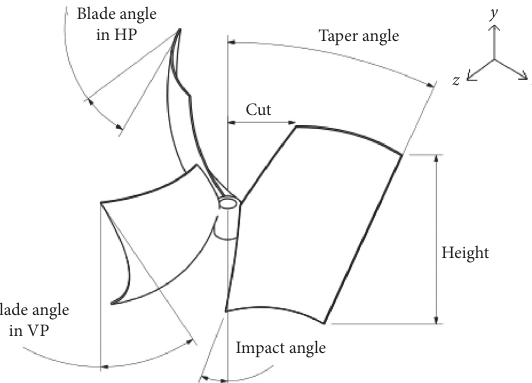
Figure 3: 3D view of parameters studied in runner